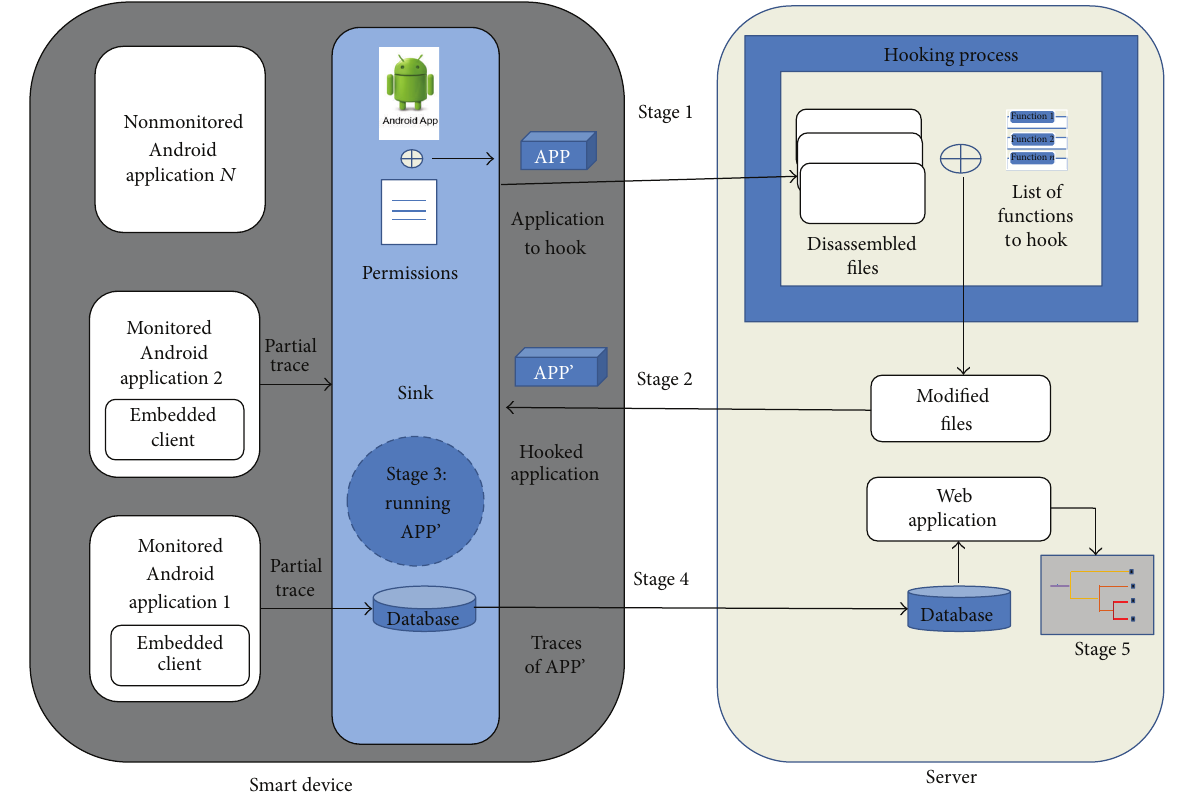
Figure 2: Schematics and logical stages of the